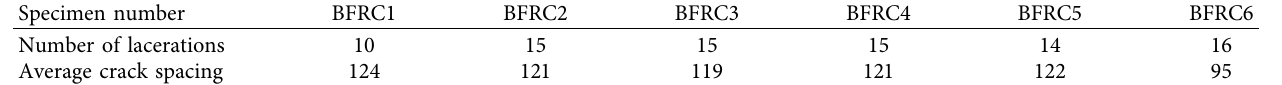
Table 7: Average fracture spacing (mm).